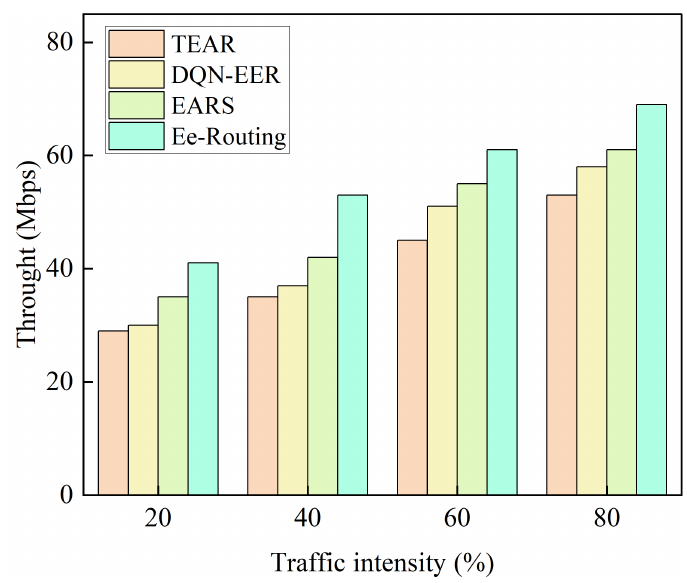
Figure 10. Throughput comparison under different traffic